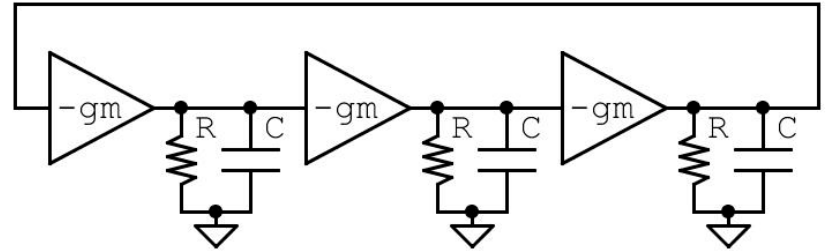
Figure 1. Ring oscillator modalized using inverting stage amplifiers.